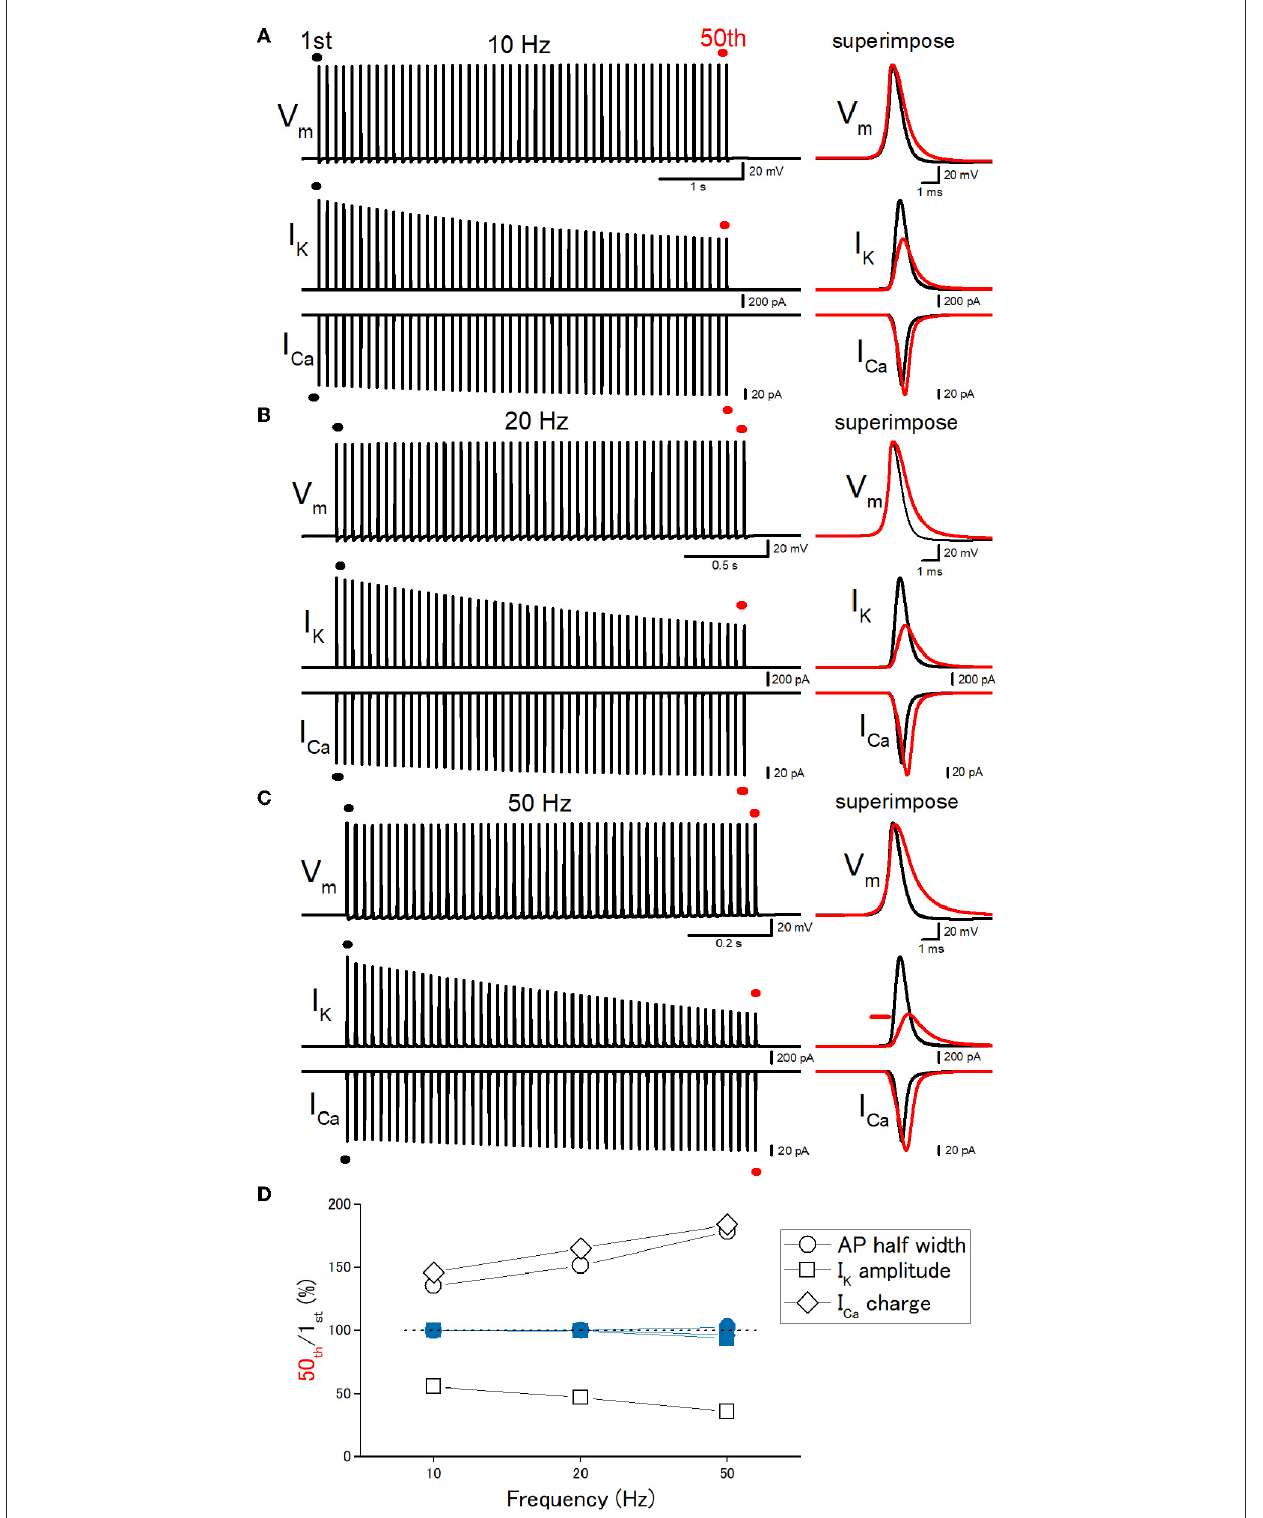
FIGURE4 Frequency dependency of the effects of repetitive stimulation. (A) Simulated propagating action potentials at the mossy fiber bouton (V m ), axonal K + current (I K ), and presynaptic Ca 2 + currents (I Ca ) elicited by the repetitive stimuli of 50 times at 10Hz. (B) Action potentials elicited by the repetitive stimuli of 50 times at 20Hz. (C) Action potentials elicited by the repetitive stimuli of 50 times at 50Hz. In each right panel, the responses to the 50th stimulus (red traces) were superimposed with that elicited by the 1st stimulus (black traces) for comparison. (D) Frequency dependency of the effects. The relative values of 50th responses/1st responses of the half-width of AP (open circles), the peak amplitude of I K (open squares), and the charge of I Ca (open diamonds). The data of the simulation using the non-inactivating I K models are similarly shown in blue